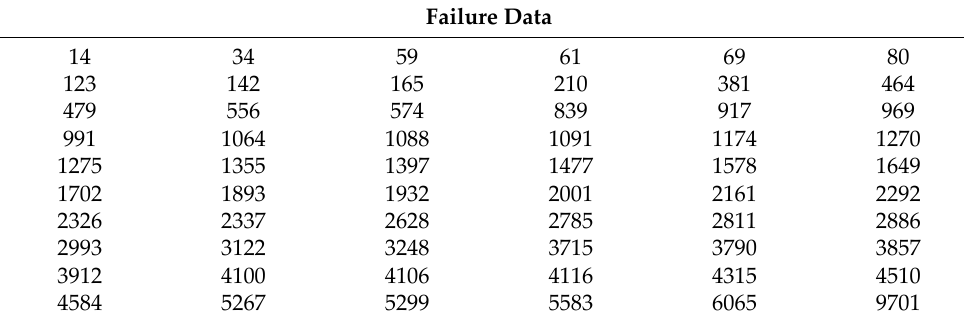
Table 3. Failure data sample